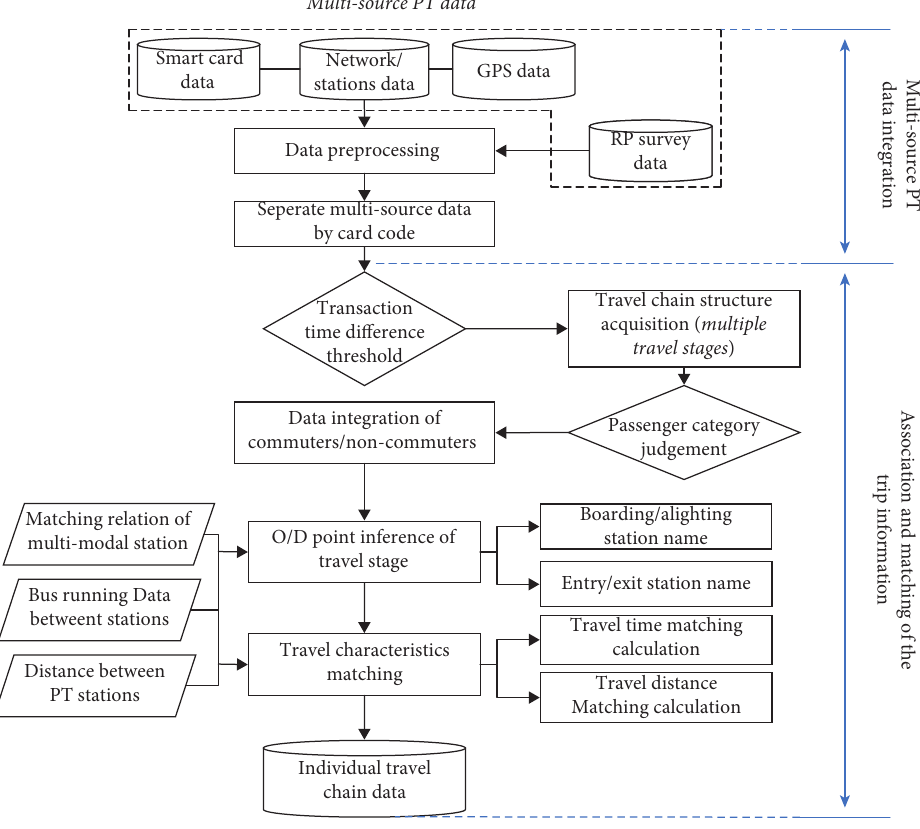
Figure 3: Extraction process of individual travel chains for PT